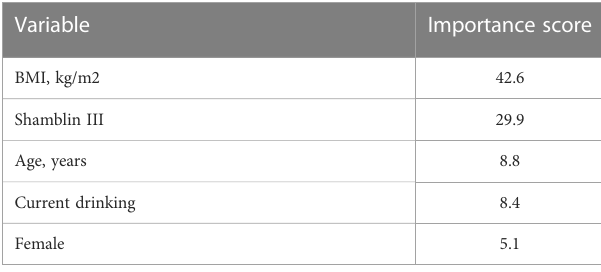
TABLE 6 Based on decision tree analysis, the following are the top 5 variables that predicted a need for preoperative embolization: BMI, Shamblin III, age, current drinking,